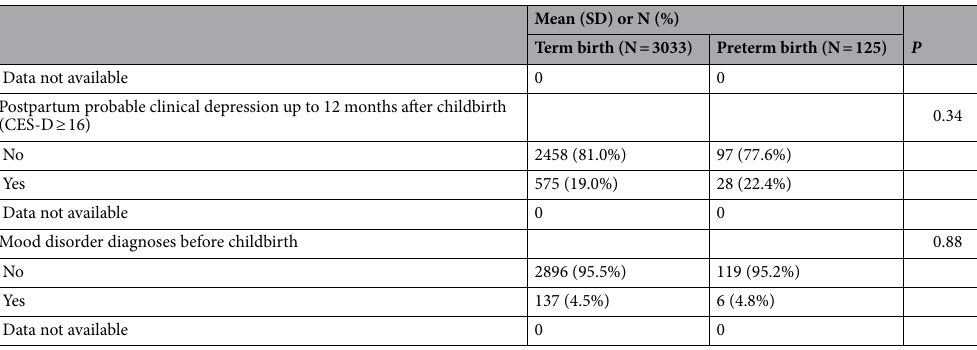
Table 1. Characteristics of the sample. CES-D refers to Center for Epidemiologic Studies Depression Scale; O-codes refer to International Statistical Classification of Diseases and Related Health-problems 10th revision.